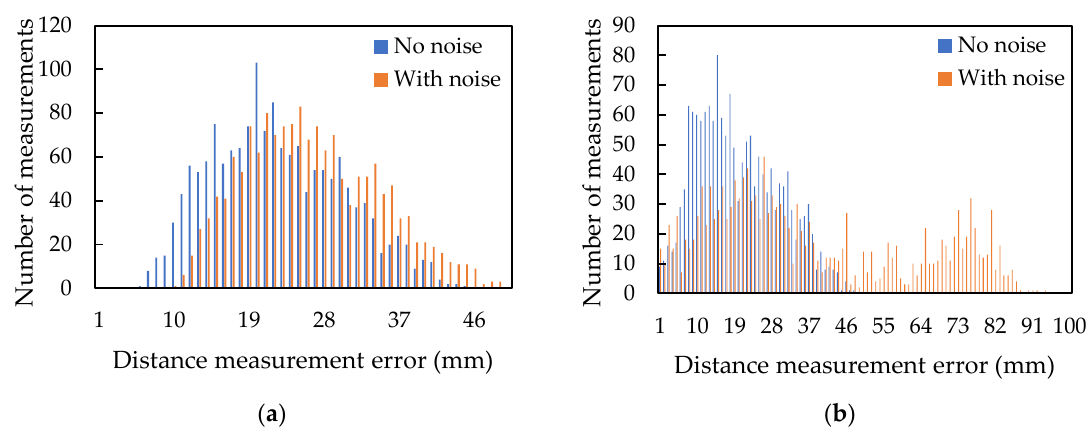
Figure 13. Histogram of the absolute distance measurement error of TDMA ( a ) and FDMA ( b ) signals.